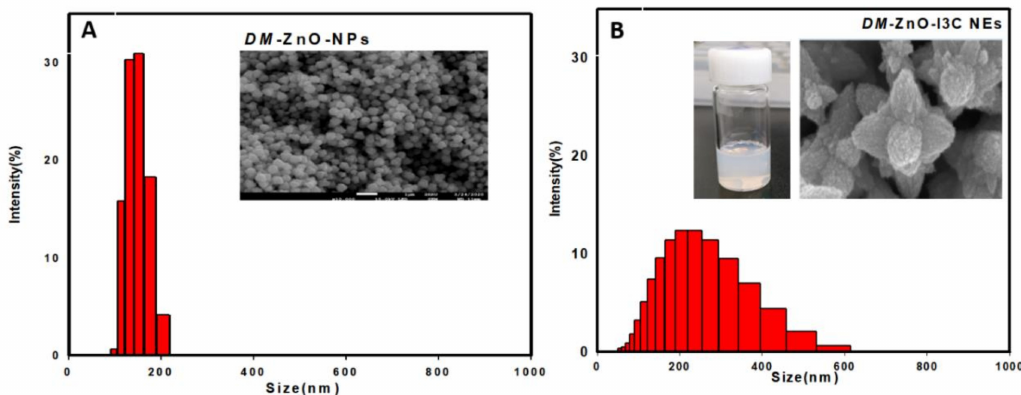
Figure 7. Size distribution analysis using dynamic light scattering (DLS) analyzer for ( A ) DM -ZnO NPs ( B ) DM -ZnO-I3C